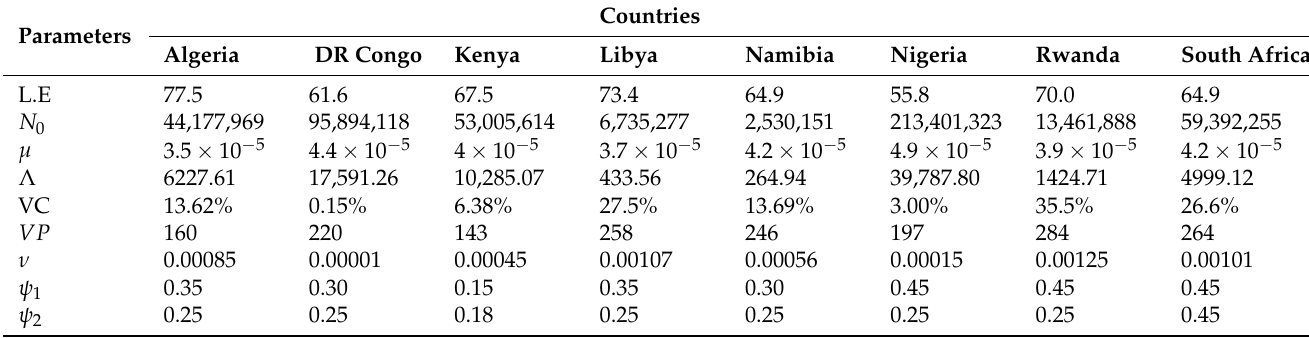
Table A3. Fixed parameters, their values and sources varying per country.